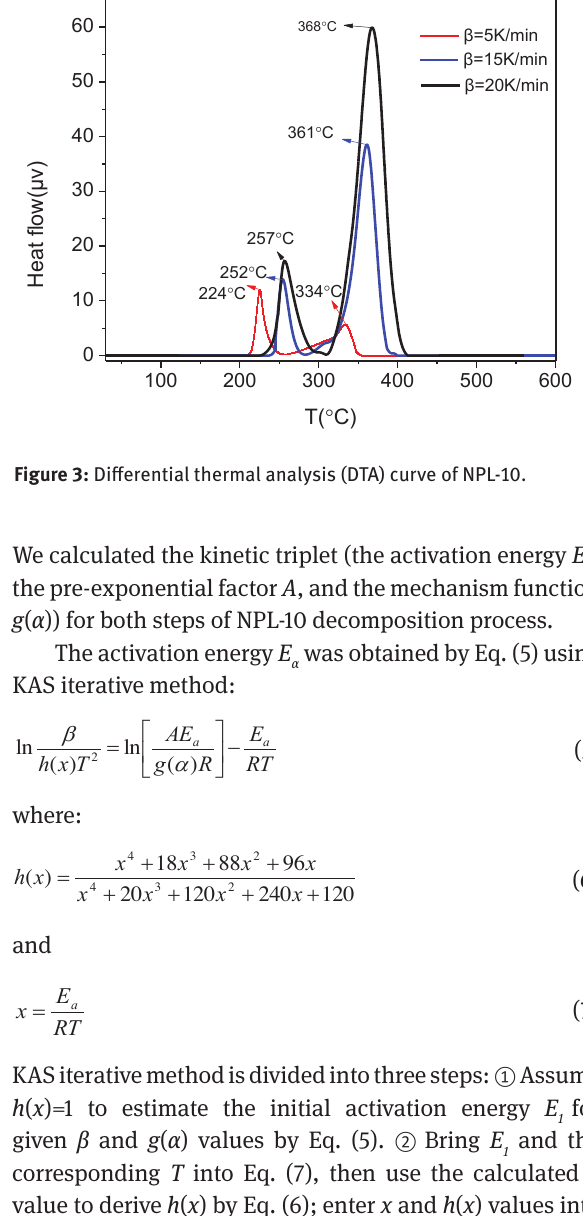
Table 2: Activation energies calculated by KAS iterative